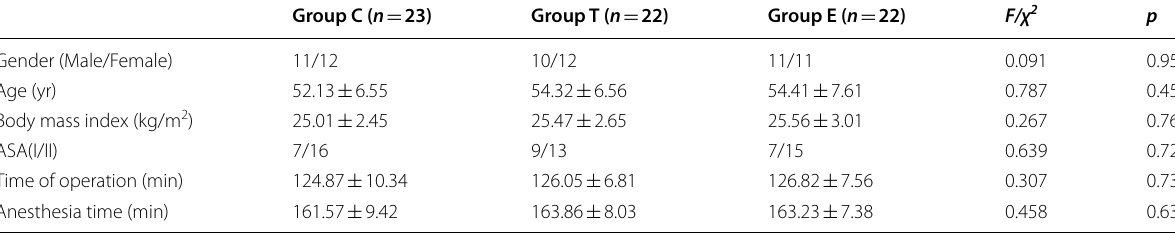
Table 1 Comparison of general data of patients in the three